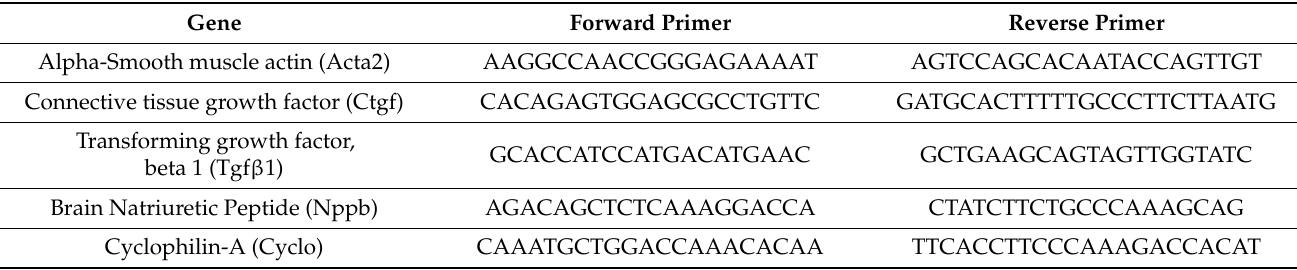
Table 1. Gene specific primer sequences used for real-time qPCR.